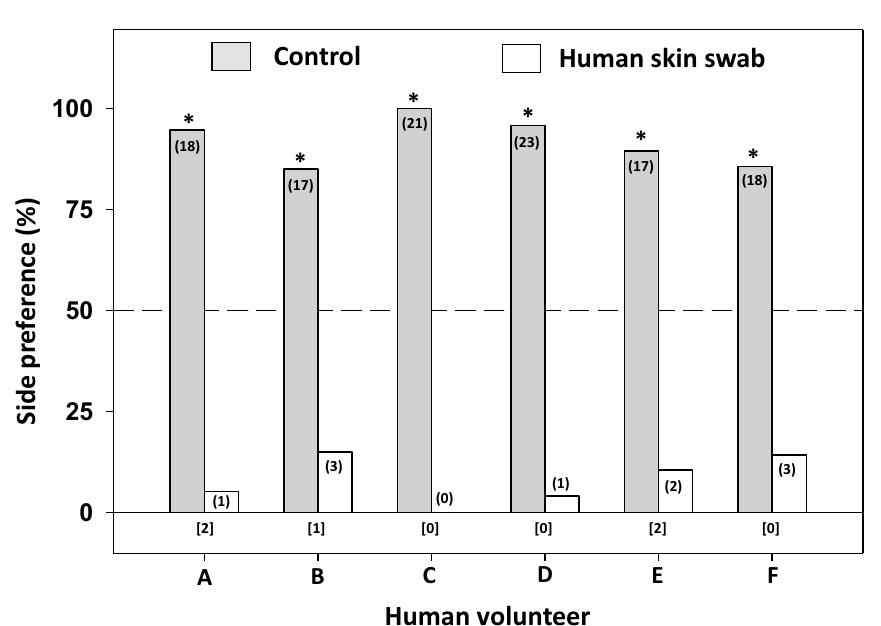
Figure 3. Responses of bed bugs to human skin swabs from different human volunteers. An asterisk (*) indicates a significant preference for one side of the two-choice assay (Chi-square test, P < 0.05). The number of bed bugs that responded is indicated in parentheses for each choice, and the number of bed bugs that failed to respond (i.e., rested on neither of the two shelters) is indicated in brackets below each set of choices for each